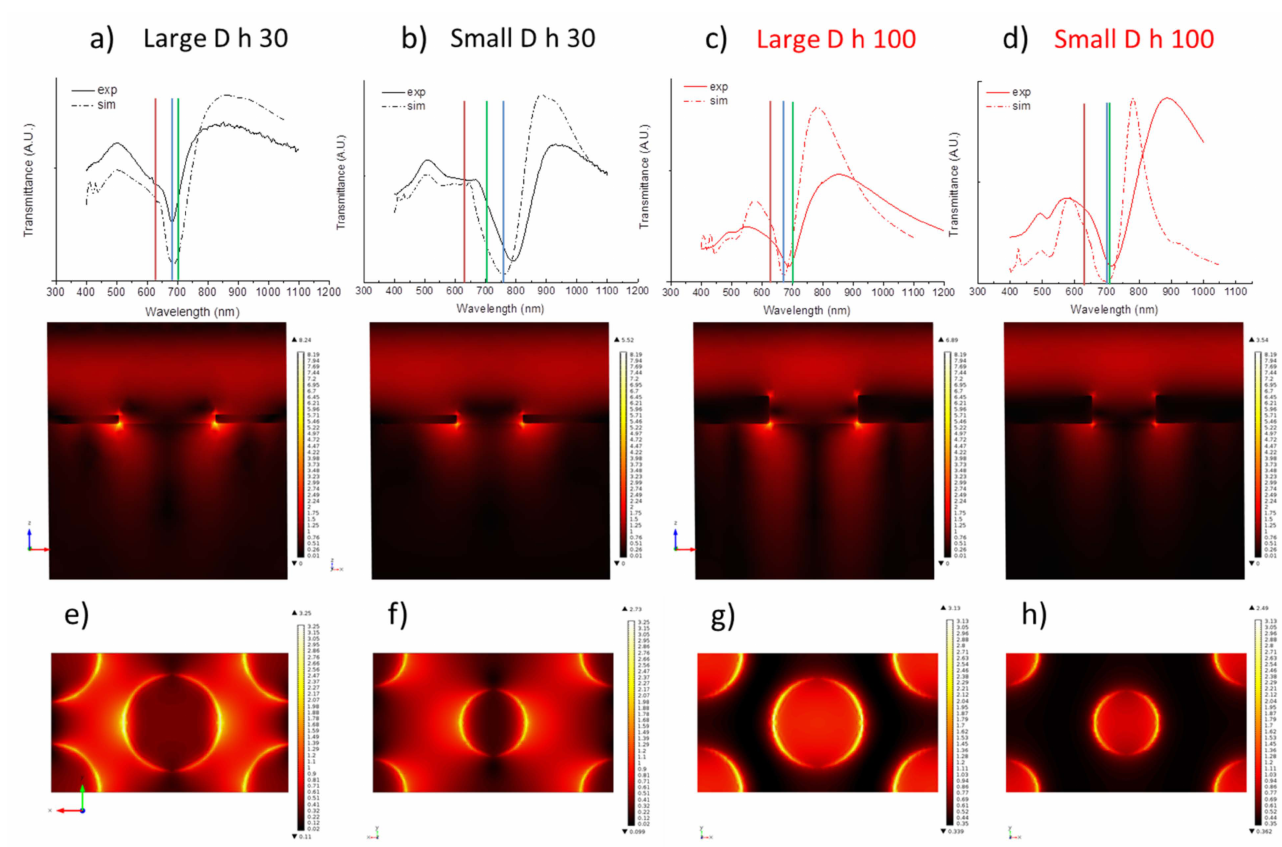
Figure 5. ( a – d ) Simulated (dashed lines) and experimental transmittance spectra showed together for comparison. Vertical lines indicate the position of the excitation wavelength (red), the strongest minimum wavelength λ 3 (blue), and the Raman band position of the selected Raman probe (green). ( e – h ) Vertical (top) and horizontal (bottom) cross sections of the local fields distribution at the strong minimum position λ 3